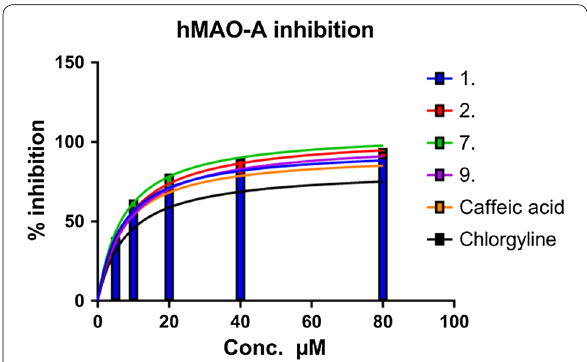
Fig. 3 Concentration-dependent hMAO-A inhibition by most active compounds